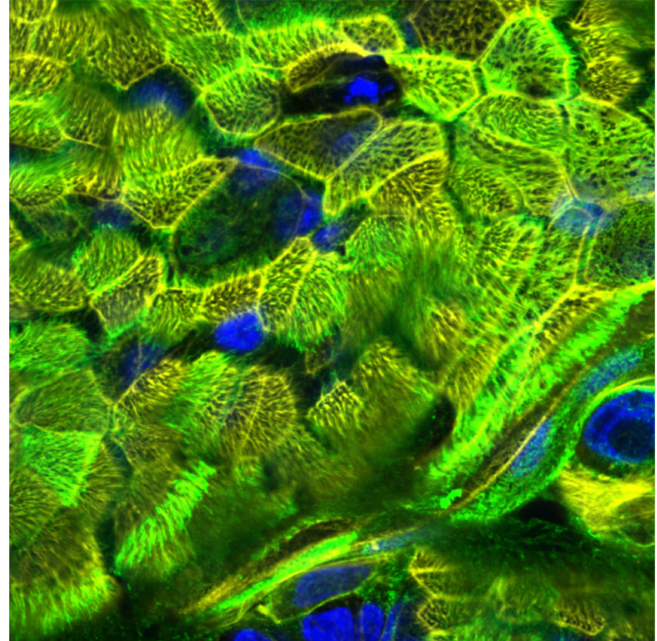
Figure 5. Analysis of epithelial integrity of upside-down cultured NHBE cells on d700 in ALI. Cilia of NHBE cells cultured in GrowDex ® for 700 days in ALI and upside-down were stained using WGA-488 (green), cytoskeleton using Phalloidin-Alexa555 (yellow) and nuclei using Höchst